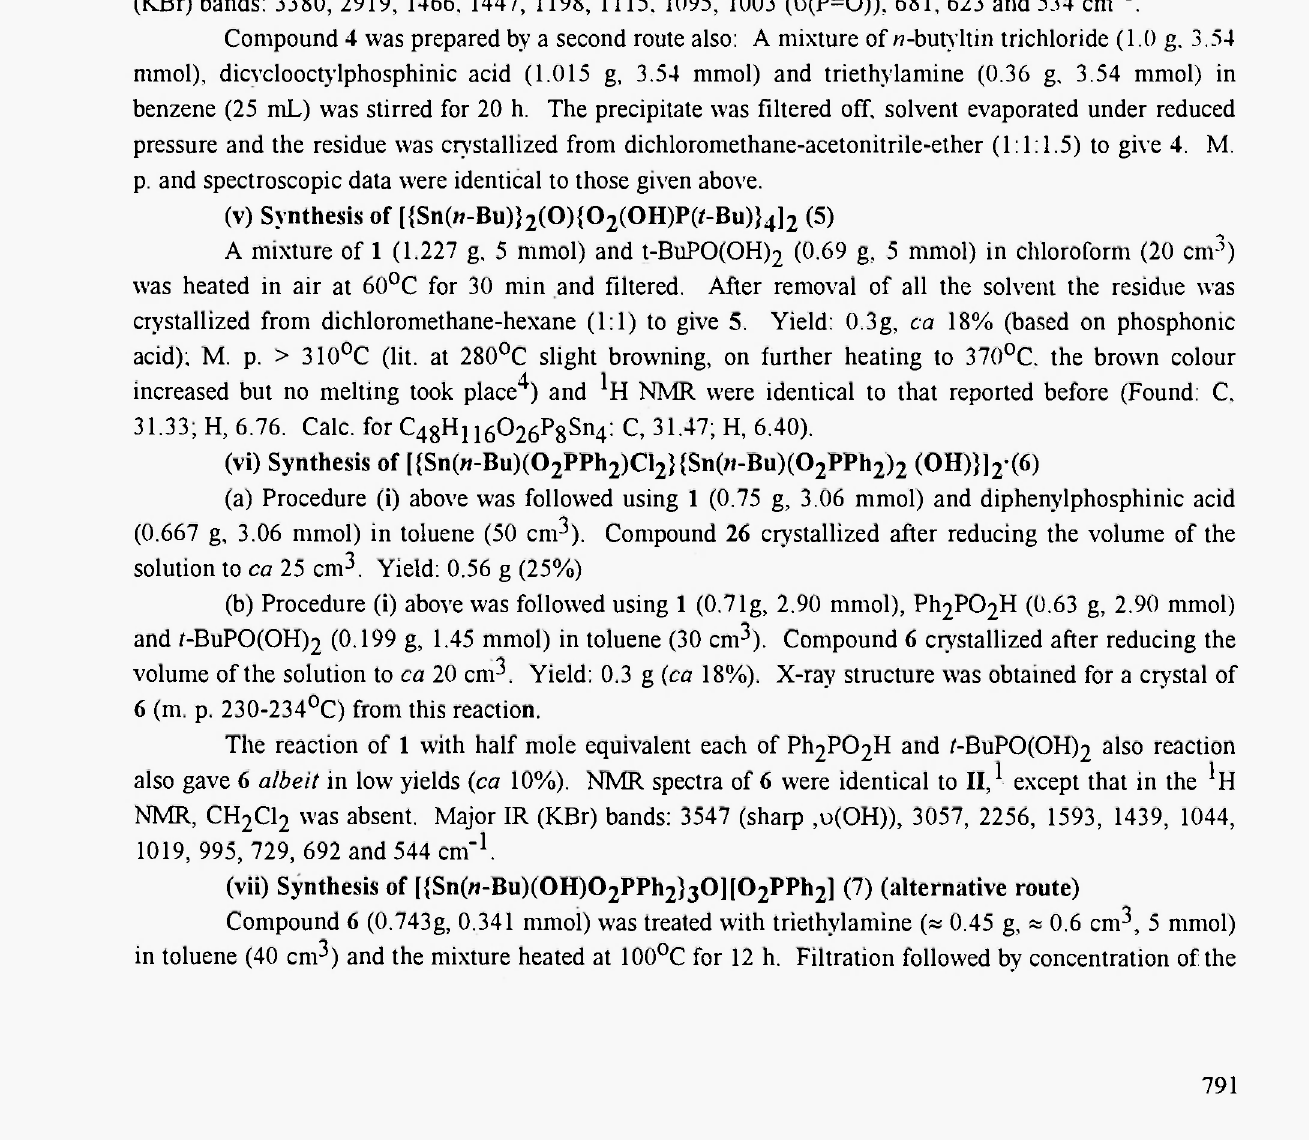
The reaction of 1 with half mole equivalent each of Ph 2 P0 2 H and /-BuPO(OH) 2 also